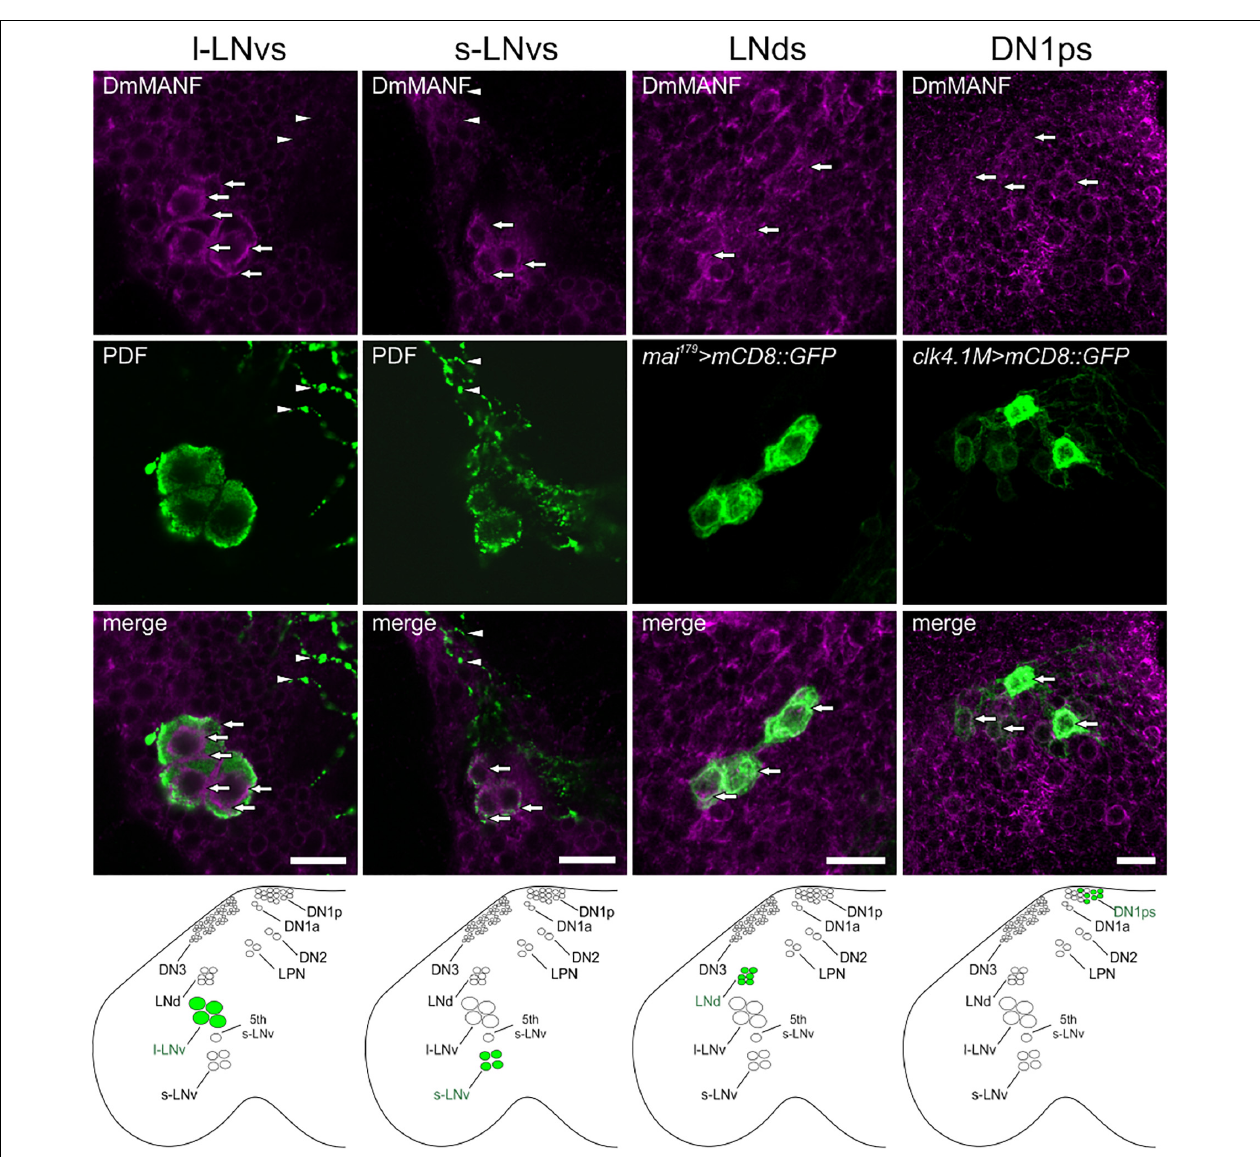
FIGURE 1 | DmMANF immunolocalization in the Drosophila pacemaker neurons. Co-labeling of DmMANF (magenta) and different clock cells (green) in the fly’s brain whole-mount. For visualization of PDF-positive l-LNv and s-LNv neurons ( N > 100), brains of Canton S flies were stained with anti-PDF serum. LNds and DN1ps were labeled with GFP-expression driven by mai 179 -GAL4 ( N = 10) and clk4.1M-GAL4 ( N = 10), respectively. Lower panel shows the schematic localization of the examined clusters of clock neurons in the fly brain. Arrows indicate expression of DmMANF in clock neurons. Arrowheads show l-LNv projections in the medulla and the lack of co-localisation with DmMANF. Scale bars: 5 µ